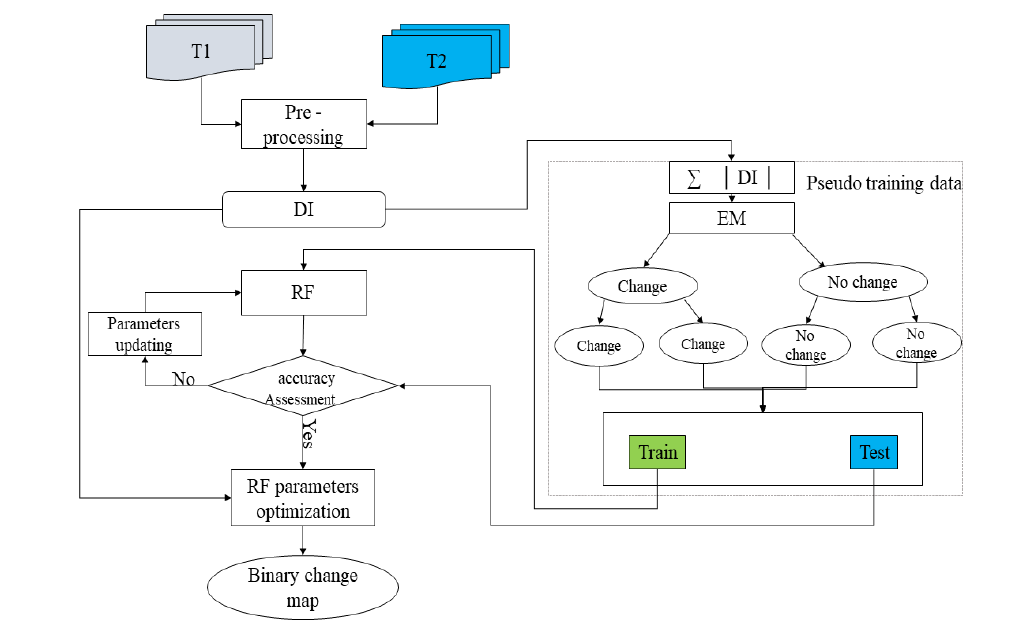
Figure 1. Proposed method